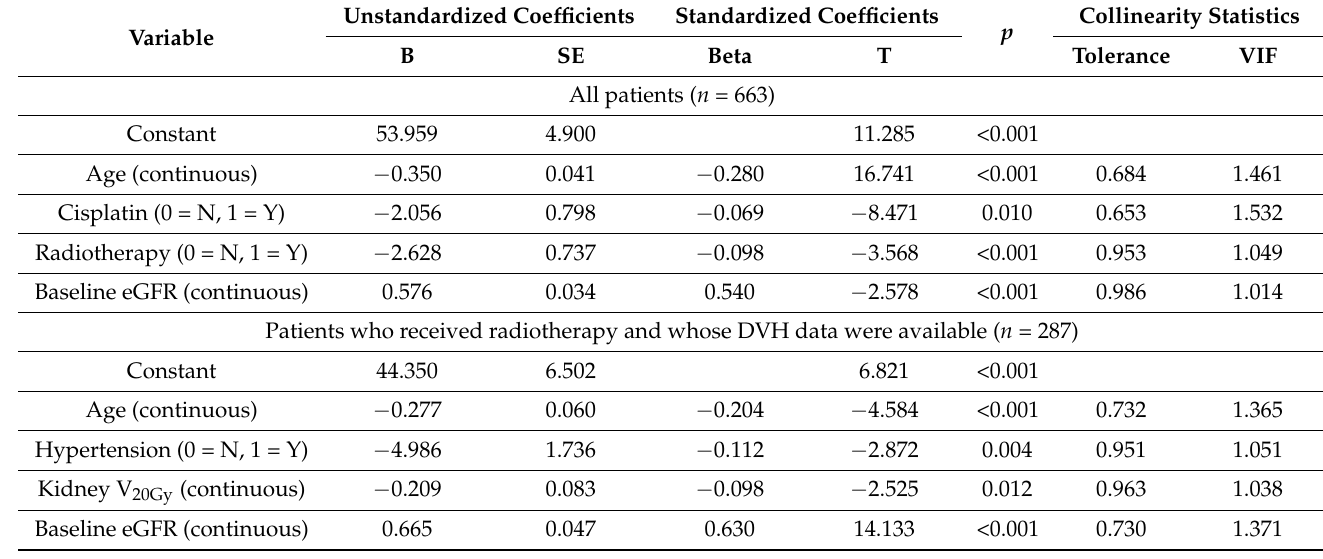
Table 3. Results of multiple linear regression